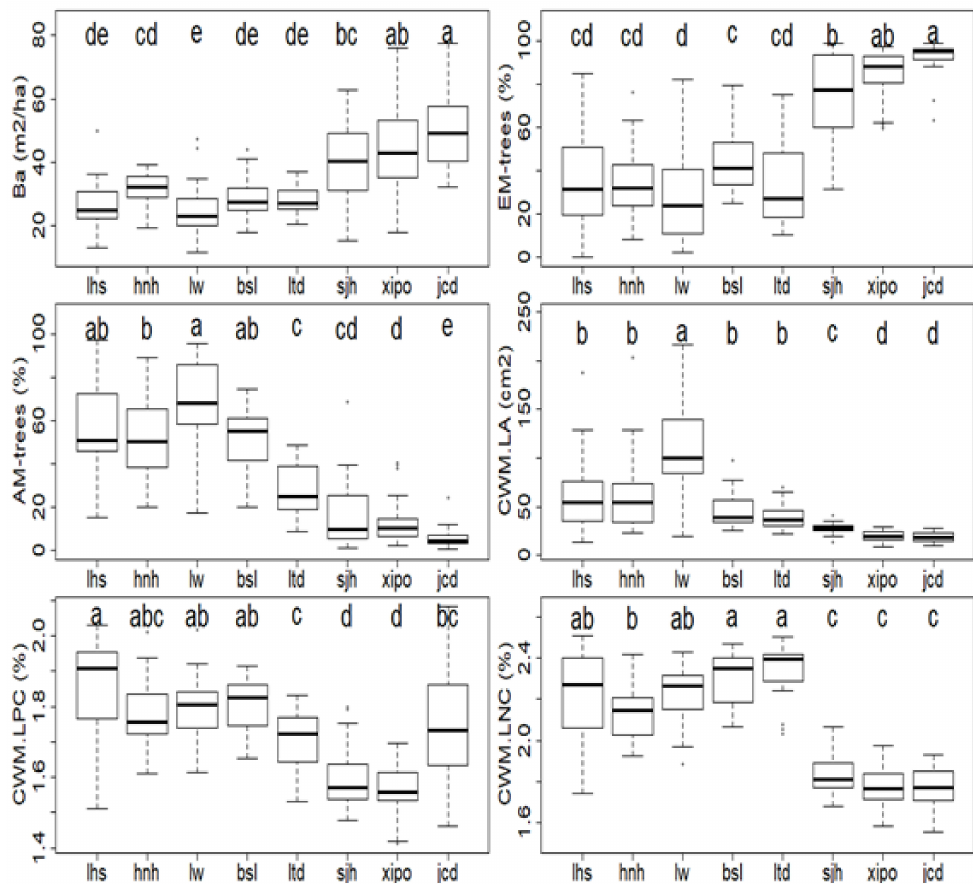
Figure 3. Plant traits along the elevation gradient. Plant traits include the basal area of all individual trees (Ba), relative abundances of ectomycorrhizal (EM) and arbuscular mycorrhizal (AM) trees, and community weighted means of leaf area (CWM.LA), leaf nitrogen content (CWM.LNC), and leaf phosphorus content (CWM.LPC). Different letters (a–e) indicate significant differences among different sampling